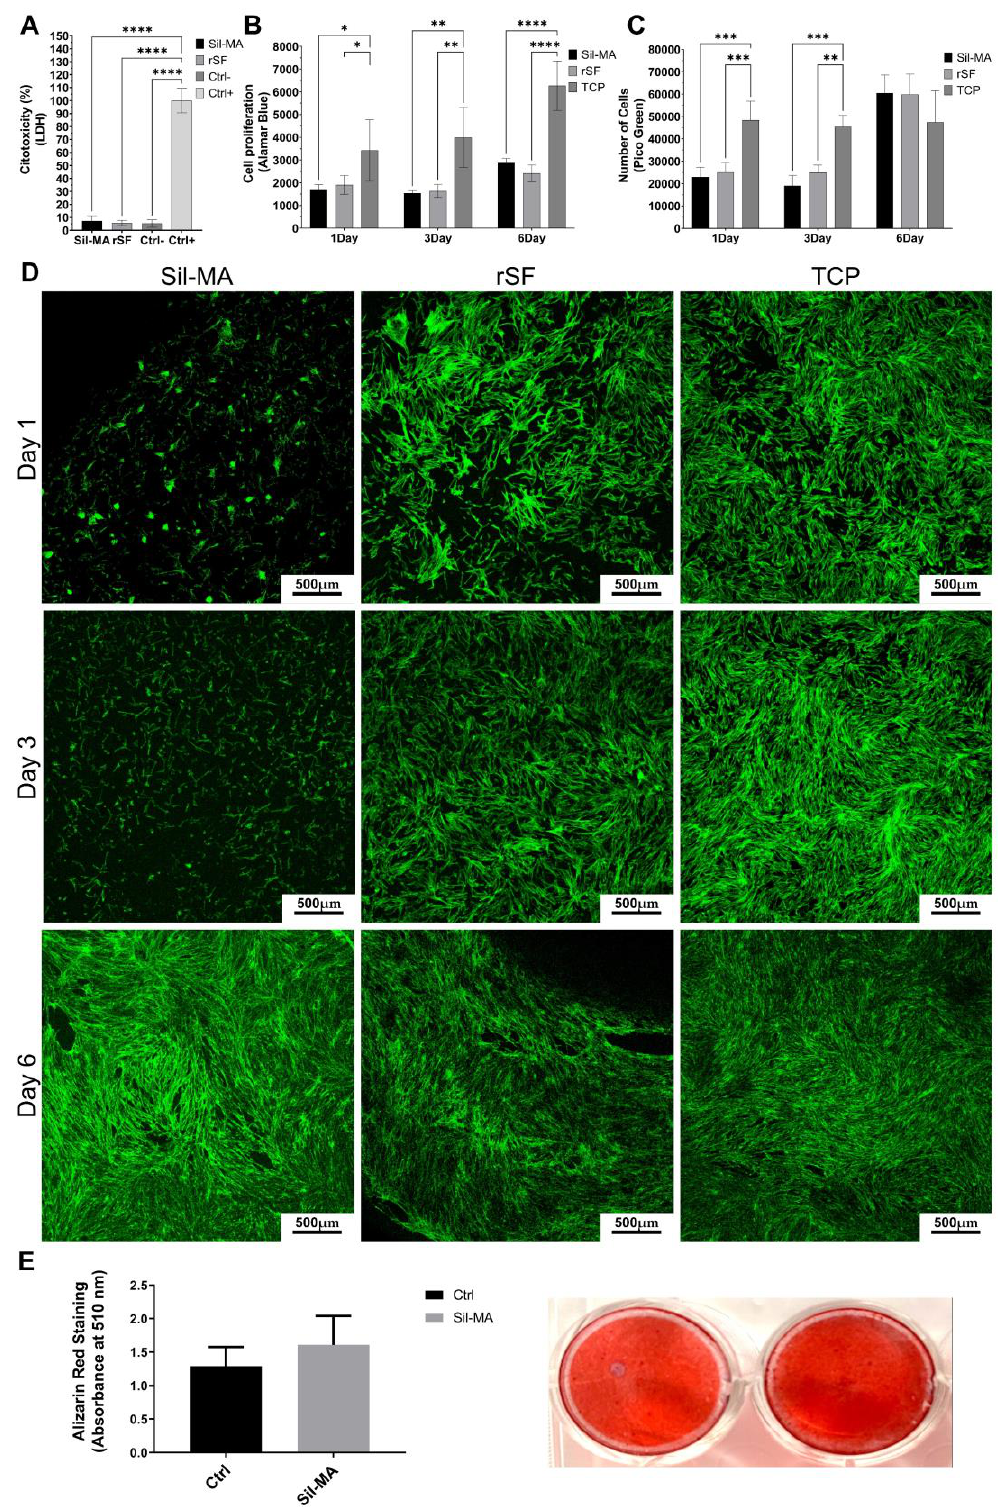
Figure 3. ( A ) Graph of LDH assay; ( B ) graph of Alamar Blue assay; ( C ) graph of Pico Green assay; ( E ) Representative confocal images on days 1, 3, and 6; ( D ) graph representing Alizarin Red staining quantification; representative images of Alizarin Red staining. Groups were considered statistically different with a p < 0.05. The confidence levels were assigned as follows: p ≤ 0.05 (*), p ≤ 0.01 (**), p ≤ 0.001 (***), p ≤ 0.0001